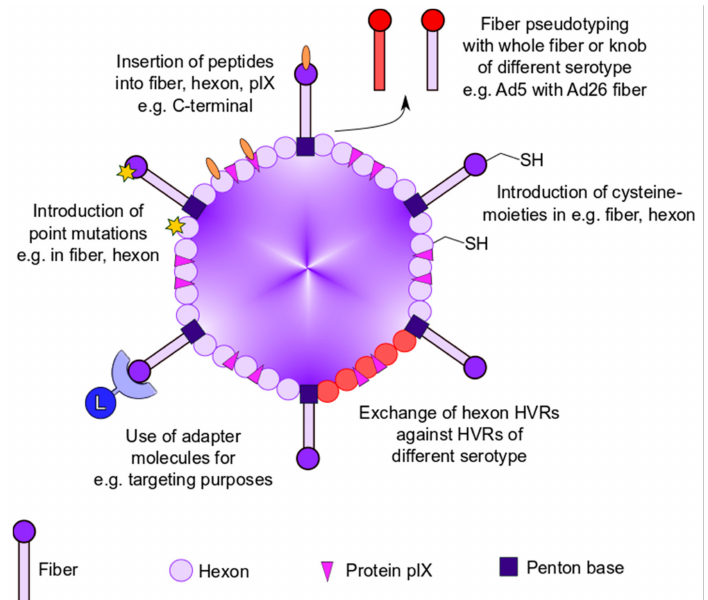
Figure 1. Overview of genetic modification strategies to modulate vector–host interaction. Genetic modification strategies for ablating viral tropism and anti-Ad immune responses by introduction of point mutations, insertion of peptides into capsid proteins, fiber pseudotyping, use of adapter molecules, or exchange of hexon hypervariable regions